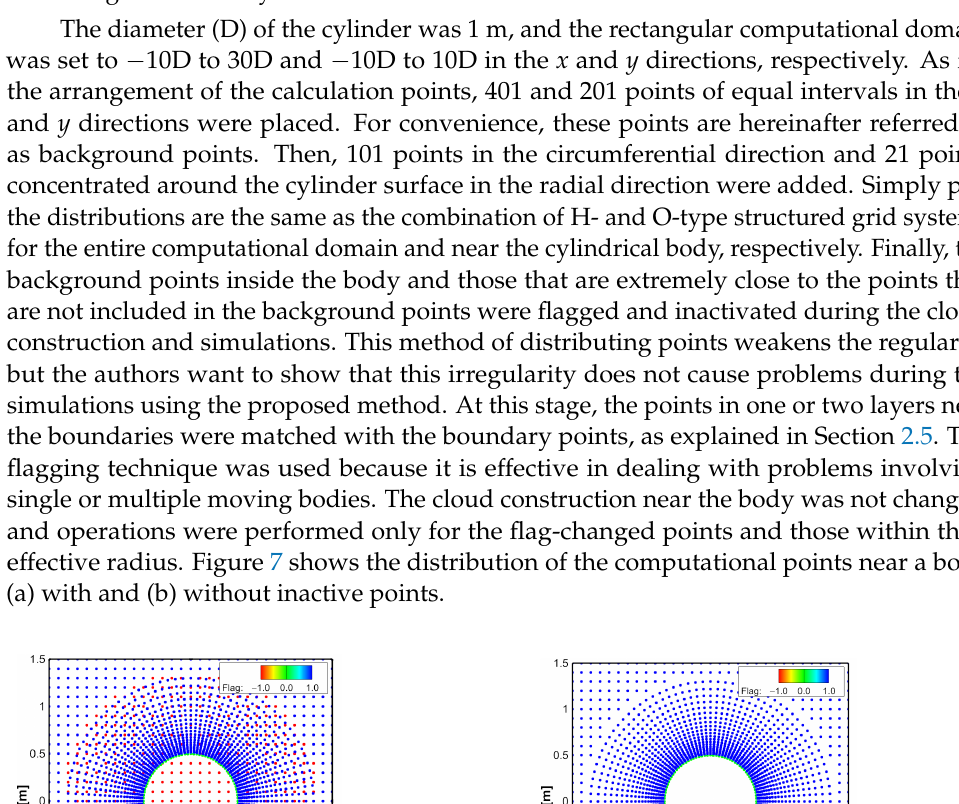
( d ) Figure 8. Contour maps of ( a ) u , ( b ) v , ( c ) p , and ( d ) vorticity magnitude around a circular cylinder ( Re = 100, t = 400 s).